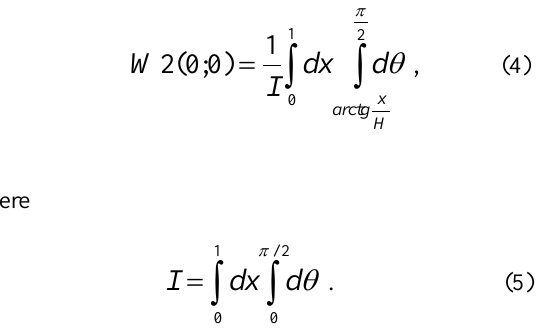
Table 3. Densities of probability distributions of collisions of atoms over the height of the system wall.